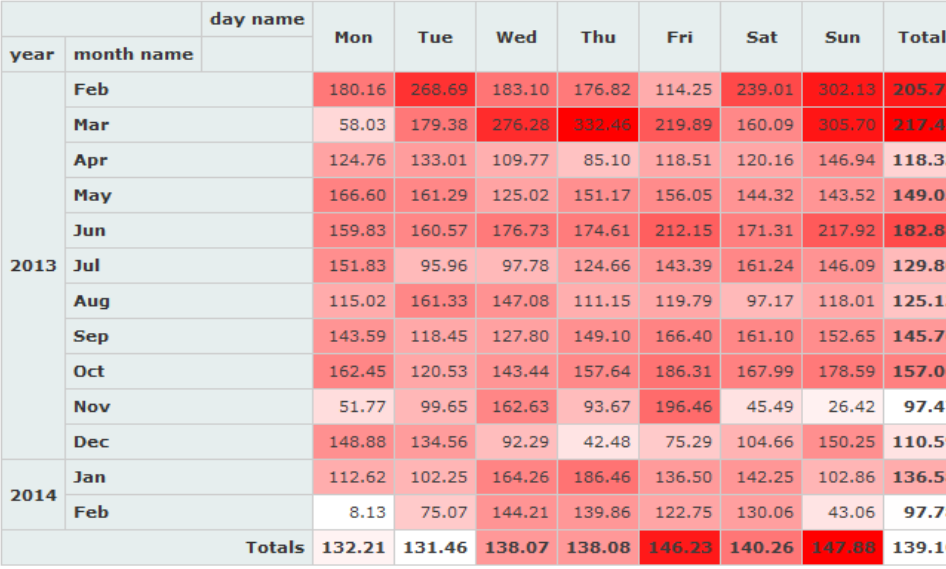
Figure 4. Heat table of month and week mean air quality index of PM 2.5 . Table 1. Visualized design for discovery of defects in the U-Air data.